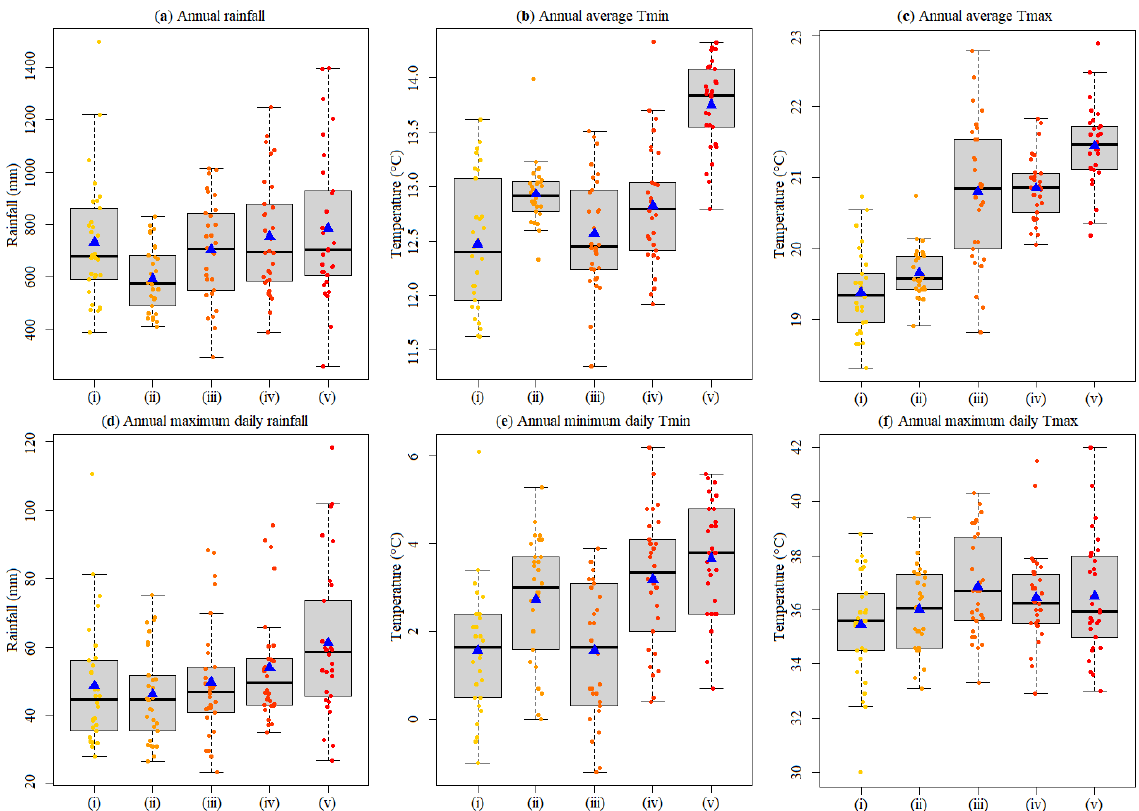
Figure 3. Climatological context at the Lisboa-Geofísico station in five consecutive periods with 30 hydrological years each from: (i) 1871/72 to 1900/01, (ii) 1901/02 to 1930/31, (iii) 1931/32 to 1960/61, (iv) 1961/62 to 1990/91, and (v) 1991/92 to 2020/21. Annual series of: ( a ) rainfall, ( b ) average Tmin, ( c ) average Tmax, ( d ) maximum daily rainfall, ( e ) minimum daily Tmin, and ( f ) maximum daily Tmax. The upper and lower parts of each box-plot are the 75th (Q3) and 25th (Q1) percentiles, respectively; the line within each box-plot is the median values (Q2); the lower and upper whiskers are Q1 × 1.5 IQR, and Q3 + 1.5 IQR, respectively, with IQR the interquartile range; the bullets are the annual data (the mean in the 30-hydrological year period is depicted with a